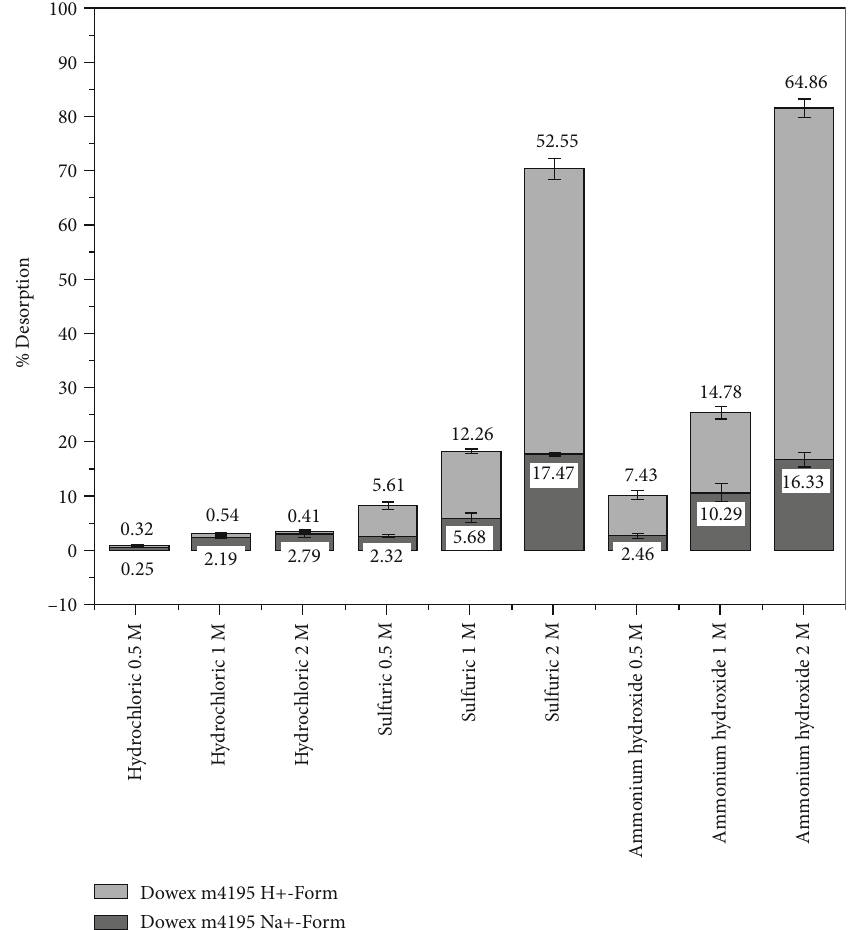
Figure 9: Desorption e ffi ciency of copper (II) ions using Dowex m4195 chelating resin as an adsorbent with 0.5M, 1M, and 2 M concentrations of HCl, H SO , and NH OH desorbing substances, 2 4 4